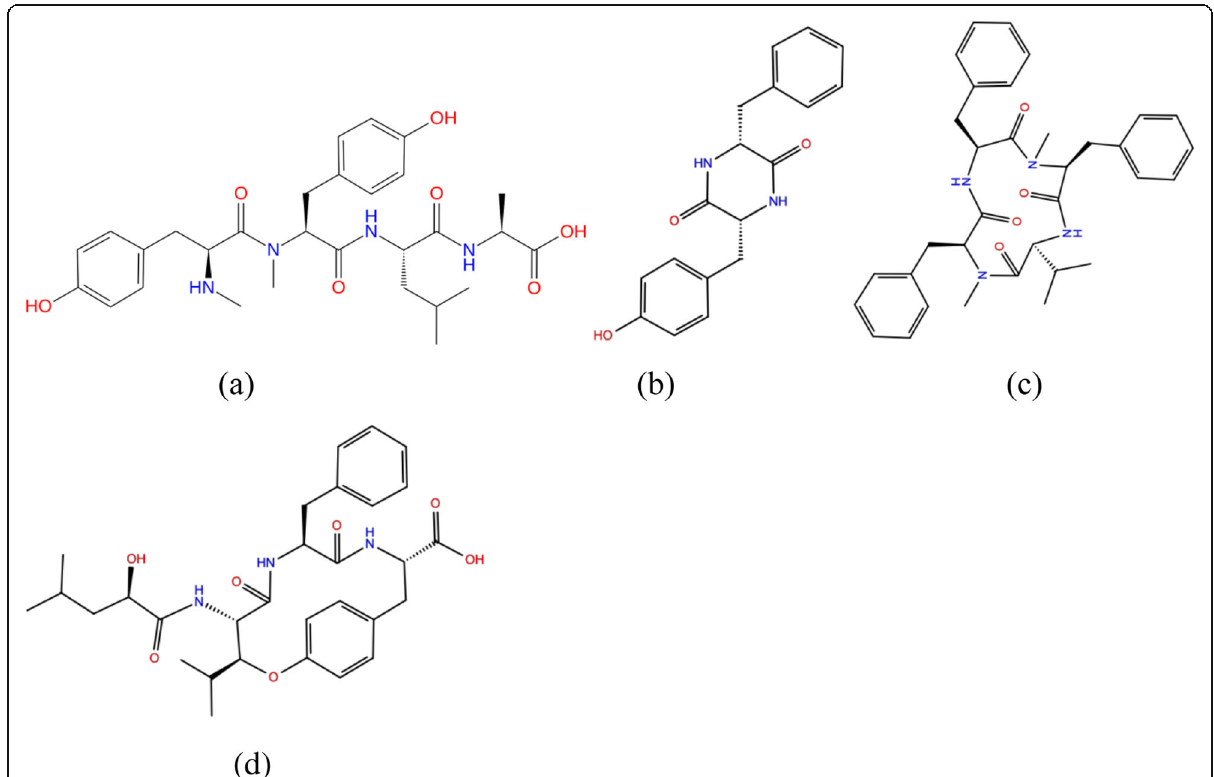
Fig. 4 2D structures of natural compounds obtained from similarity indexing. a UNPD86509. b UNPD22004. c UNPD107852. d UNPD163060